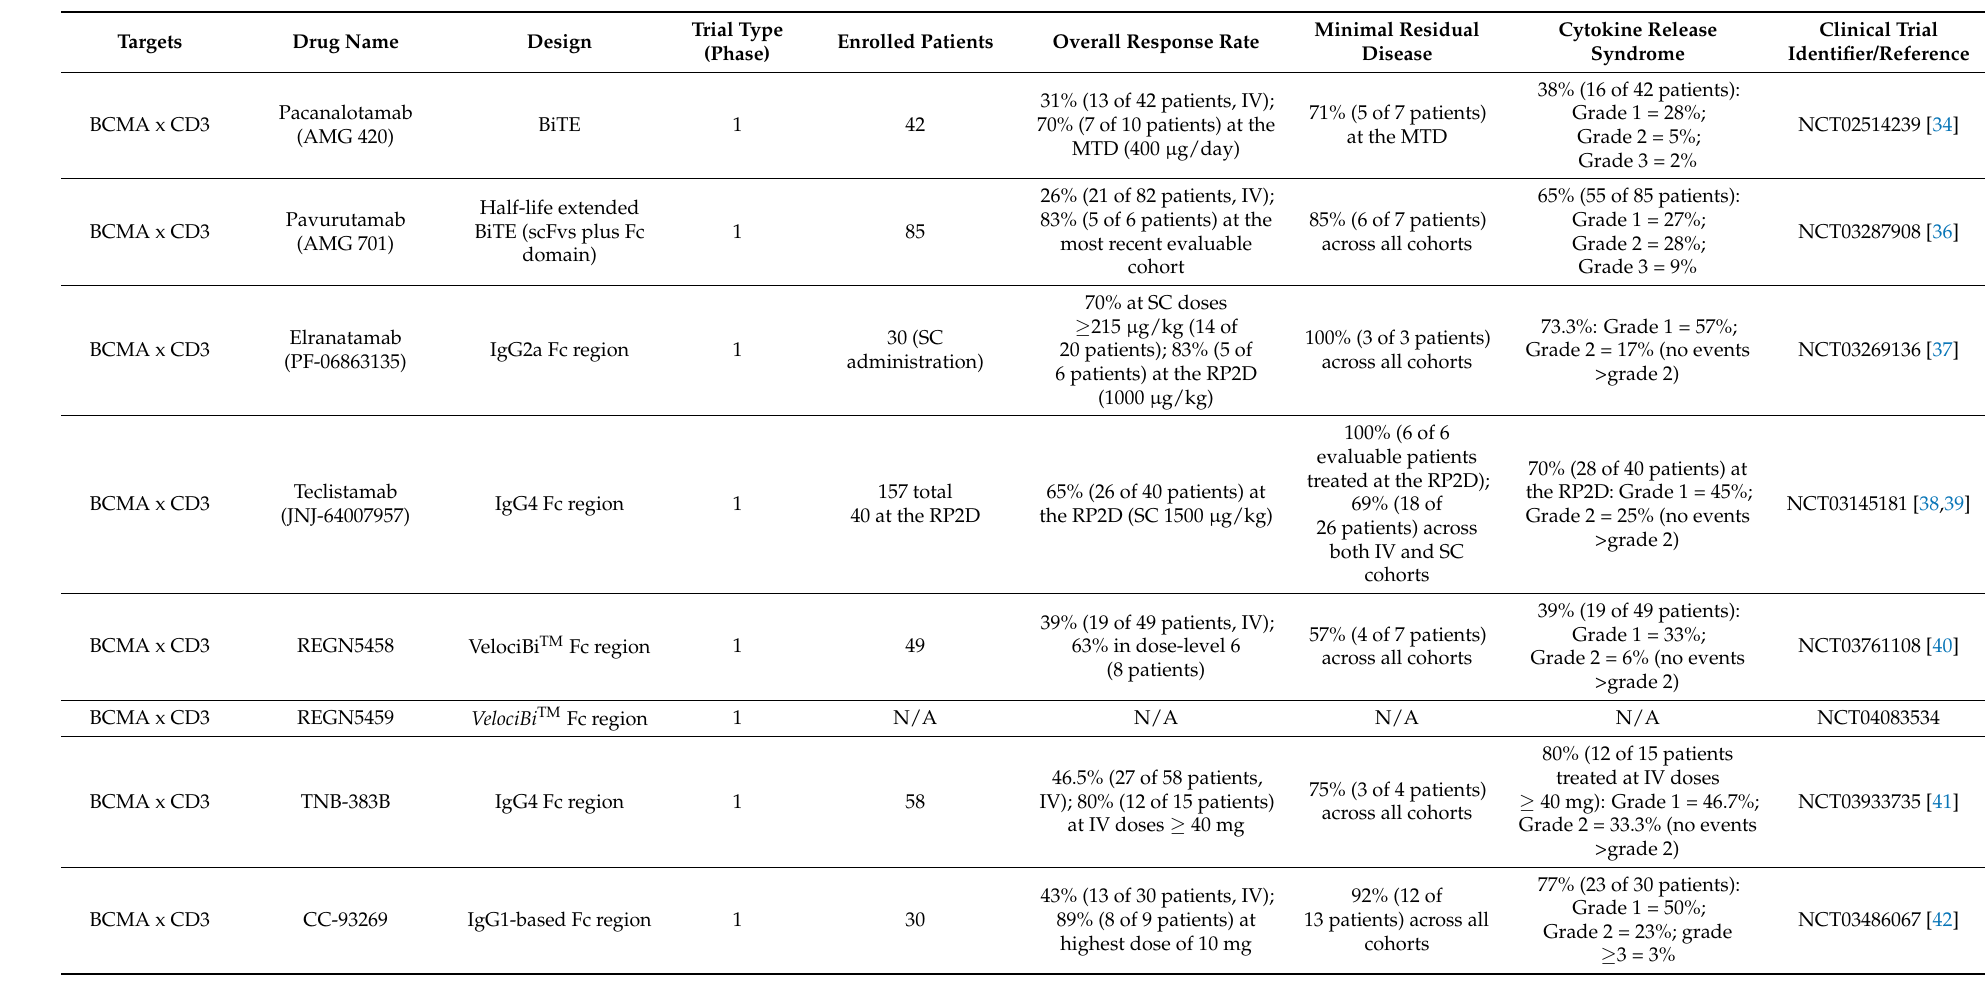
Table 1. An overview of clinical trials assessing T cell-redirecting bispecific antibodies in heavily pre-treated multiple myeloma